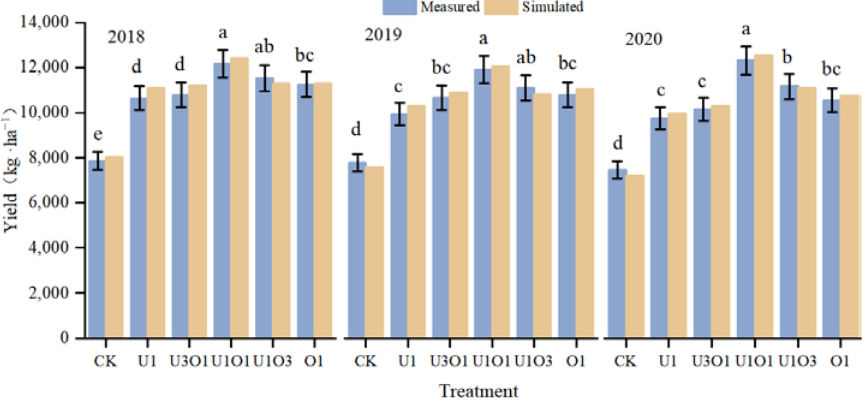
Figure 2. The modeled and measured grain yield under different treatments. Bars are the standard deviation of the measured values. Different small letters indicate significant differences ( p < 0.05) between treatments.